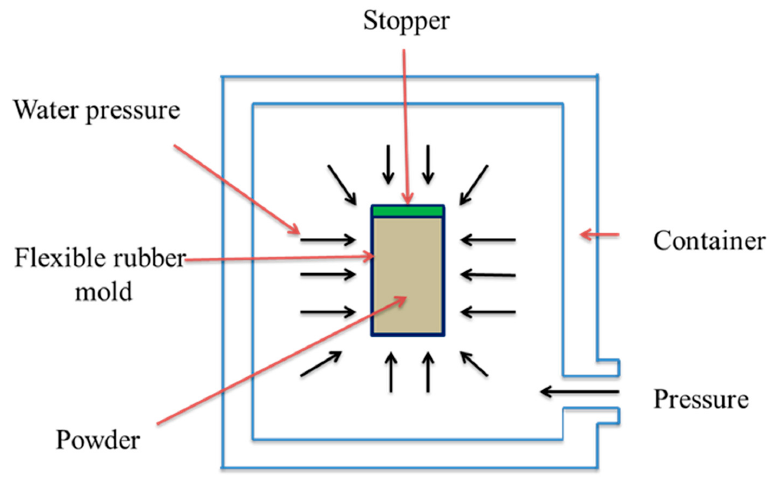
Figure 1. Schematic of cold isostatic compression of powder. The green compacts were sintered in a high-temperature sintering furnace (Xerion Advanced Heating ® Ofentechnik GmbH, Berlin, Germany) at 500 °C for two hours under an argon atmosphere. The sintering scheme is shown in Figure 2. The sintered billets were then machined to a size of 35 mm (diameter) × 40 mm (height). The resultant machined billets were homogenized at 400 °C for one hour and then hot extruded at 350 °C. The extrusion ratio was set to 20.25:1 to produce 8-mm diameter rods. Figure 3 shows the images of sintered billets and the extruded rods of the samples.